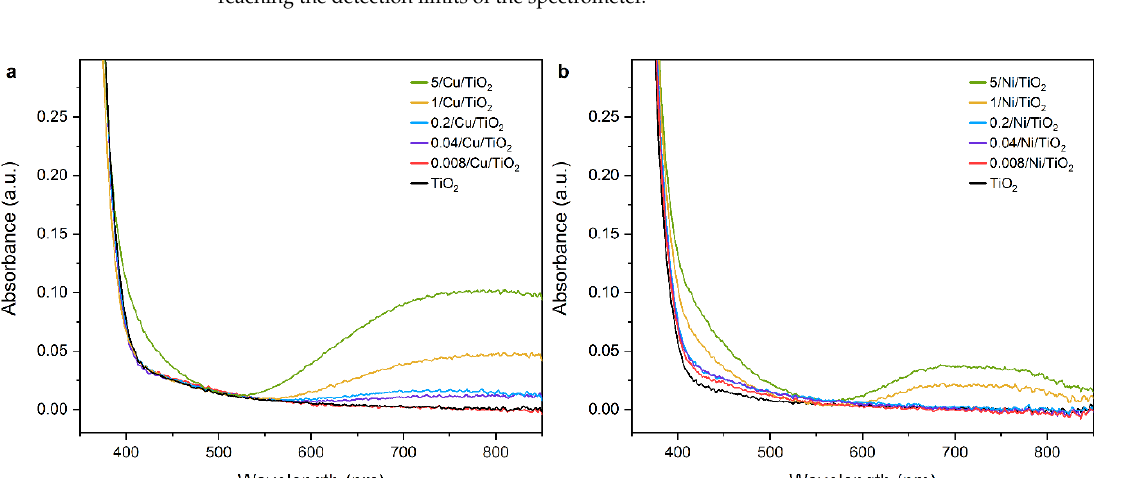
2 and ( b ) Ni/TiO 2 composite